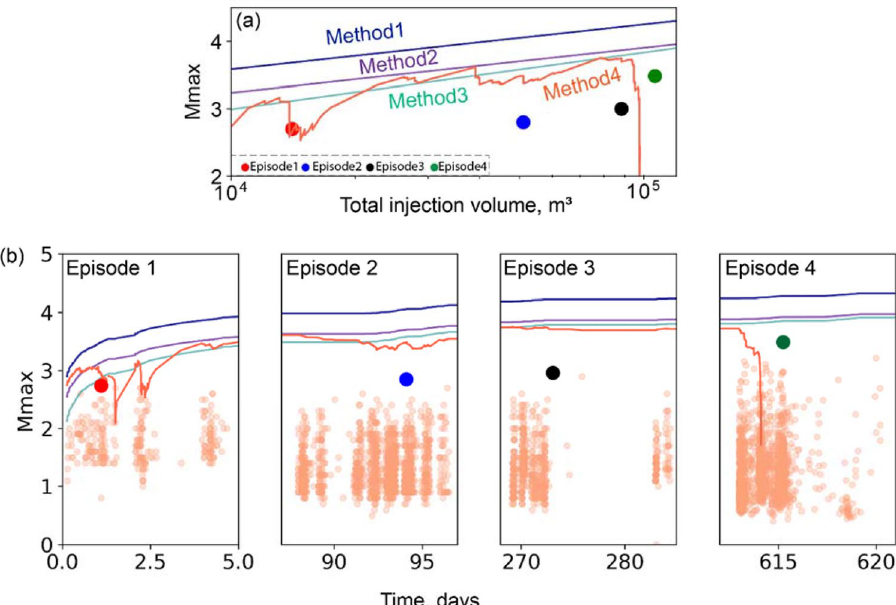
Figure 7. Comparison of estimated upper limits of seismic event magnitude in project area two. ( a ) Estimated M max versus total injection volume for the four short-term forecasting methods. Only events above the magnitude of completeness (1.5 M W ) are considered for models 1–4. Red, blue, black, and green symbols show the largest observed induced seismic events during each episode. ( b ) Estimated M max versus time, zoomed in to each injection episode. Observed magnitudes for all events are shown by small orange symbols, while the large symbol in each panel indicates the largest-magnitude event (by episode).